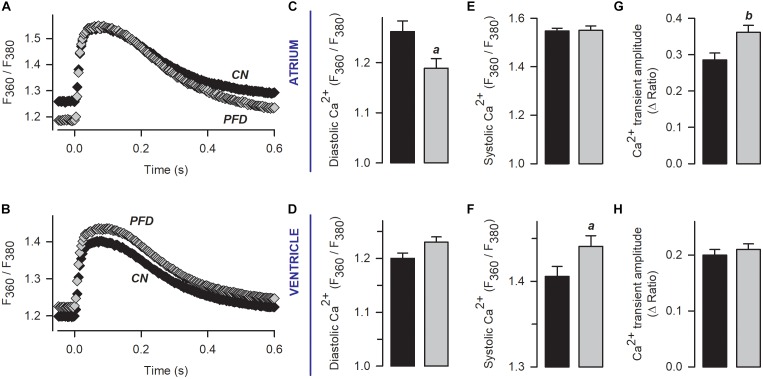
Pirfenidone enhances CICR in intact (non-patch clamped) myocytes. (A,B) Mean values of Ca2+ transients that were obtained from electrically stimulated atrial (A; 42 CN, 37 PFD) and ventricular (E; 81 CN, 80 PFD) myocytes. Average values (mean ± SEM) of diastolic (C,D) and systolic (E,F) Ca2+ are also shown, along with the maximum amplitude of the Ca2+ transient (G,H). Black and gray symbols/bars indicate control and PFD-treated cells. ap < 0.05, bp < 0.01.